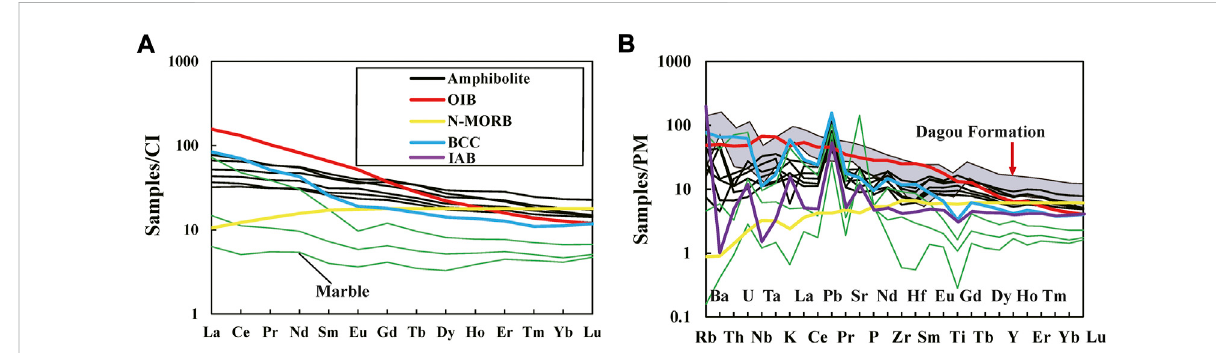
FIGURE 6 (A) Chondrite-normalized rare earth element distribution of amphibolite and other typical rock; (B) primitive mantle-normalized trace element